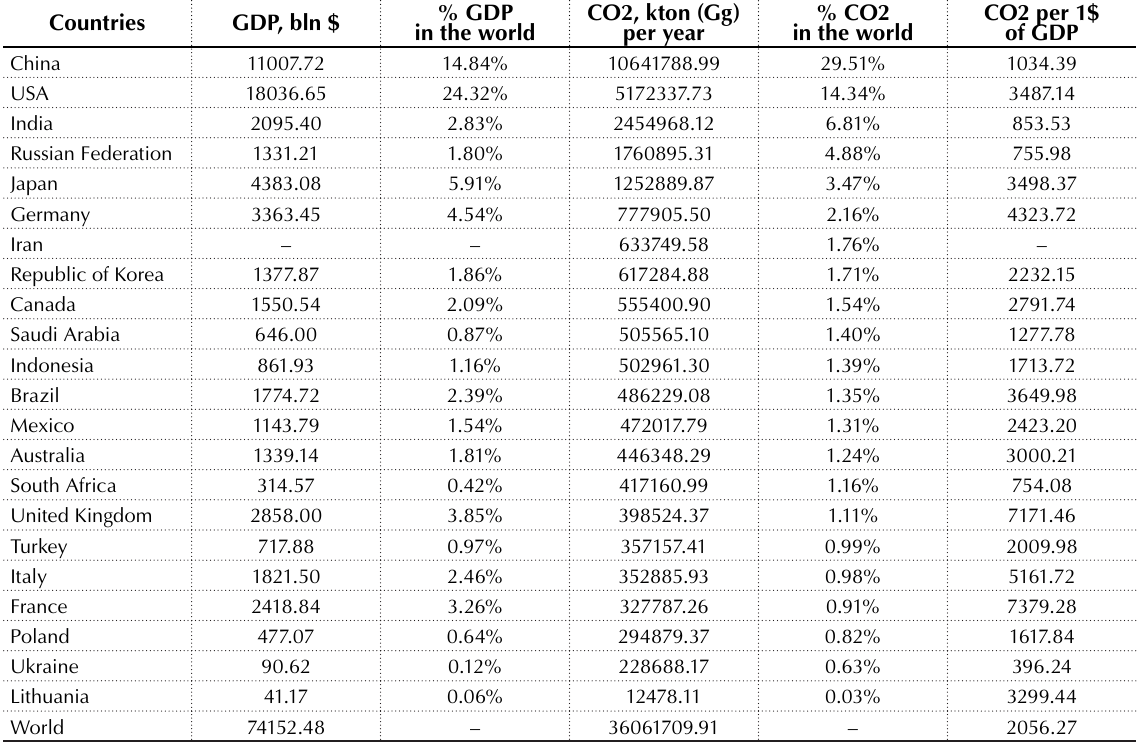
Table 4. CO2 emissions and share of the world GDP by the